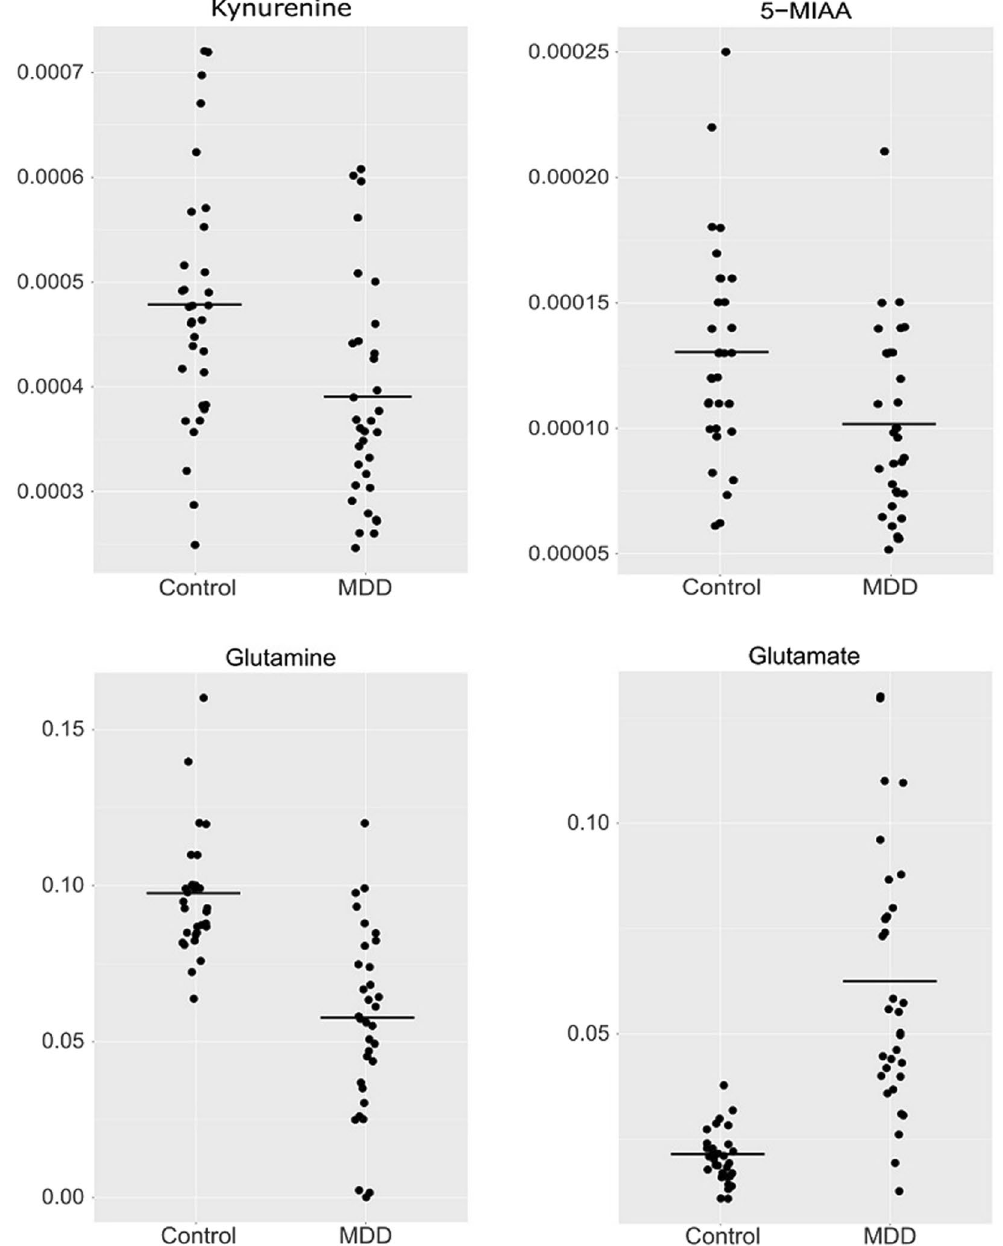
Figure 1. Plasma amino acid levels in medication-free patients with major depressive disorder (MDD) and controls. Y axis represents relative metabolic levels. Bars indicate mean levels in the group. ( a ) Kynurenine were significantly lower in MDD patients than in control subjects (FDR q = 0.0096). ( b ) The levels of 5-Methoxyindoleacetic acid were significantly lower in MDD patients than in control subjects (FDR q = 0.016). ( c ) Glutamate levels were significantly higher in MDD patients than in control subjects (FDR q = 3.7 × 10 − 7 ). ( d ) Glutamine levels were significantly lower in MDD patients than in control subjects (FDR q = 4.8 × 10 − 7